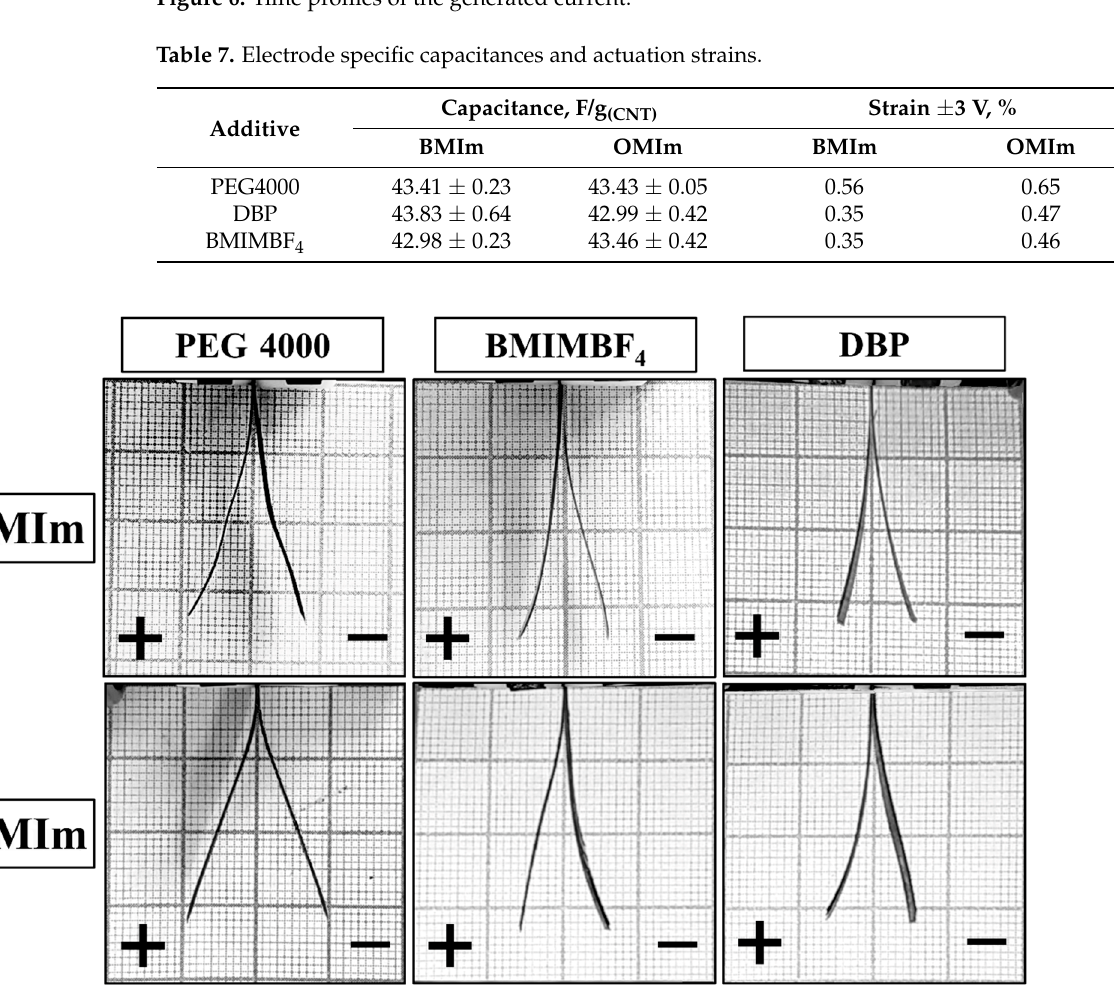
Figure 6. Time profiles of the generated current. Table 7. Electrode specific capacitances and actuation strains.